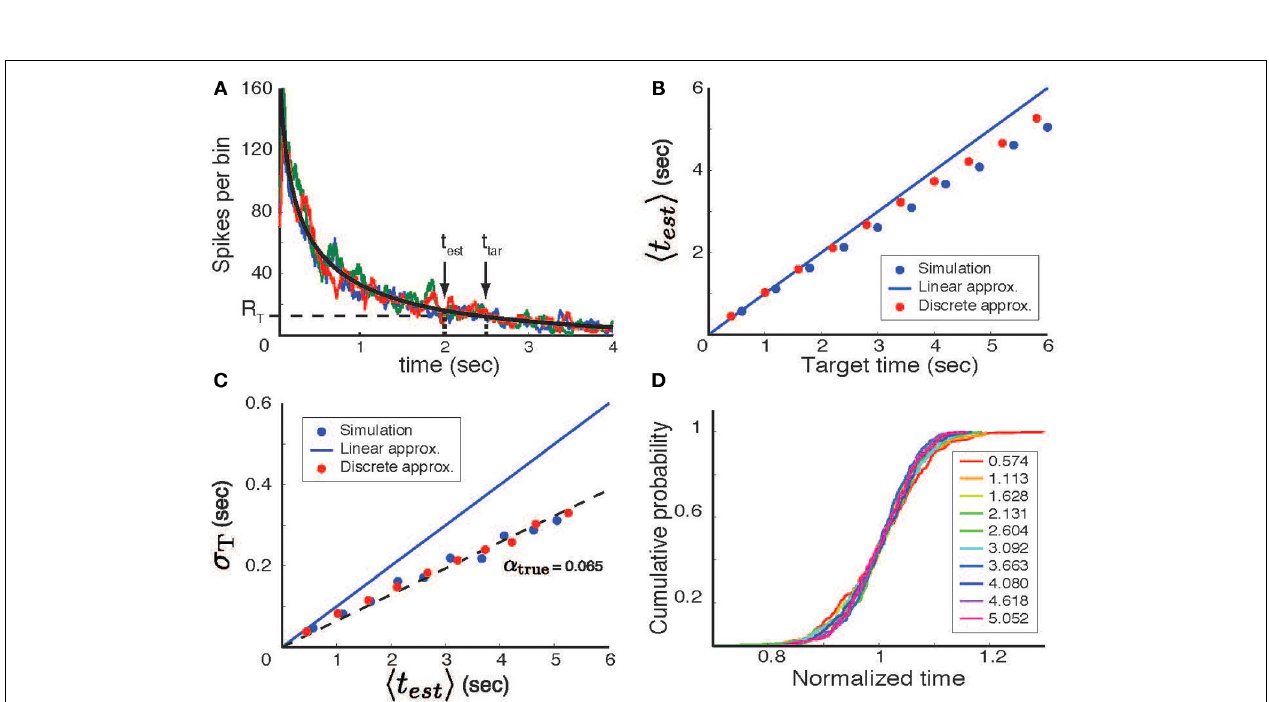
FIGURE 1 | Scalar timing and neural statistics. (A) A local linear approximation (green line, Equation 2) of the the average firing rate R ( t ) (real distribution shown schematically by the gradient as a function of t , mean and standard deviations indicated by dashed-white and solid red lines) together with the scalar timing law leads to Equation 4, the solution of which (Equation